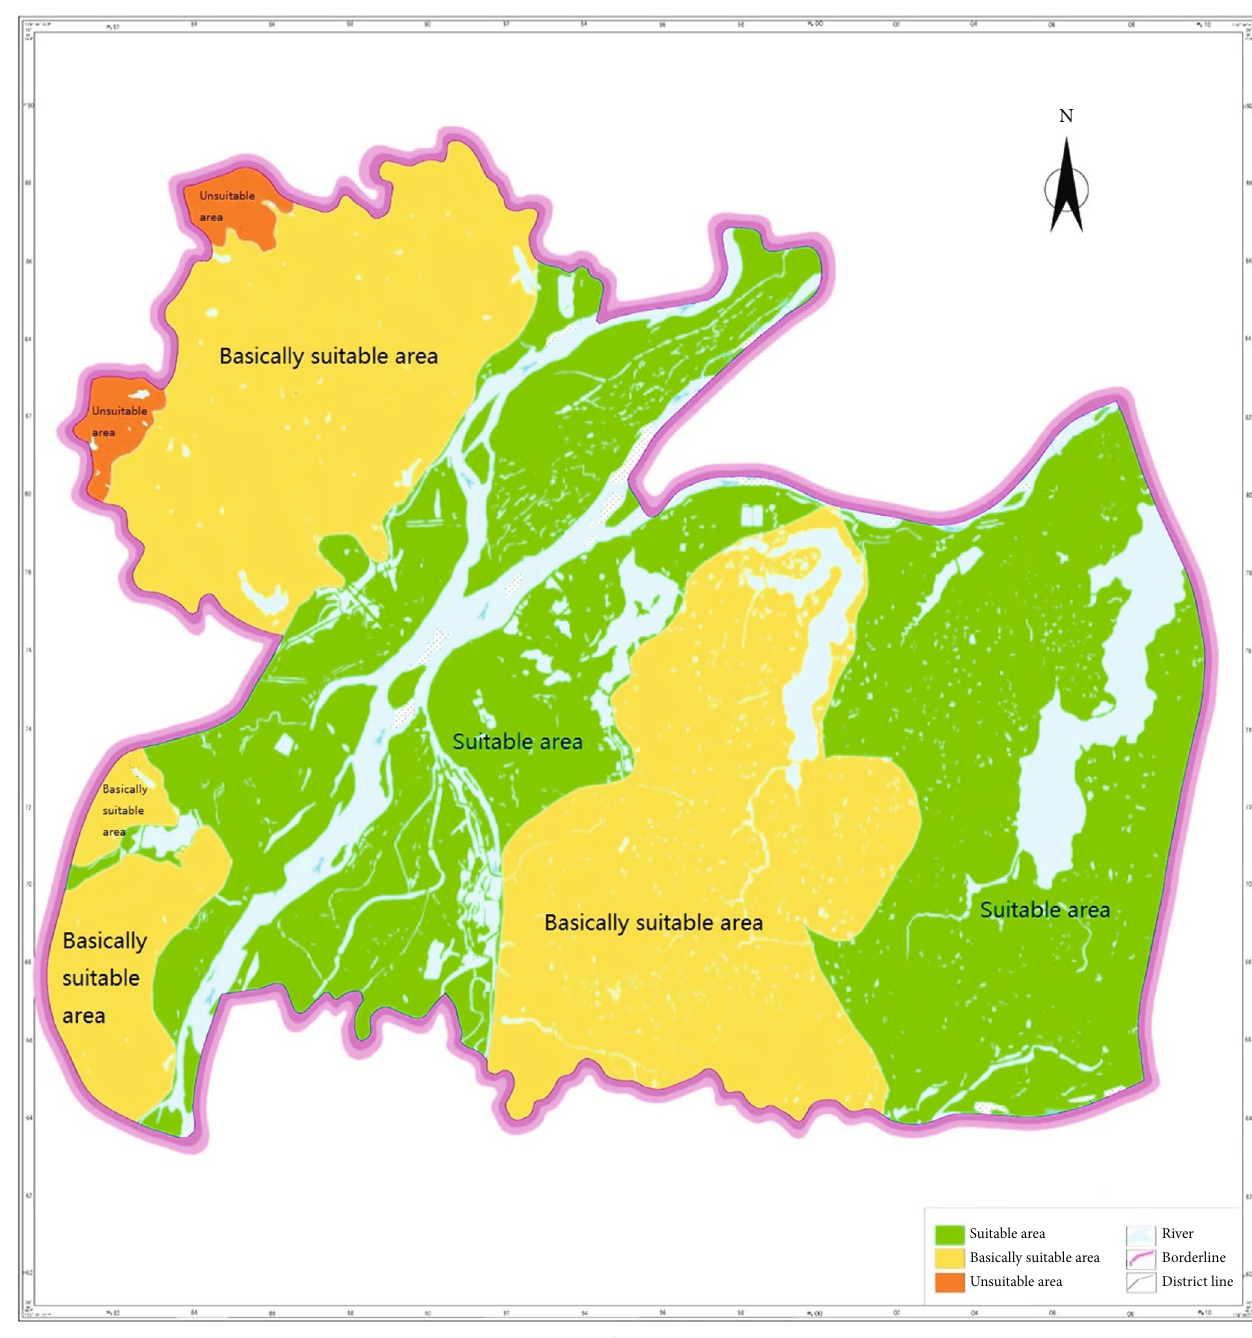
Figure 11: Suitability zoning of shallow geothermal energy development and